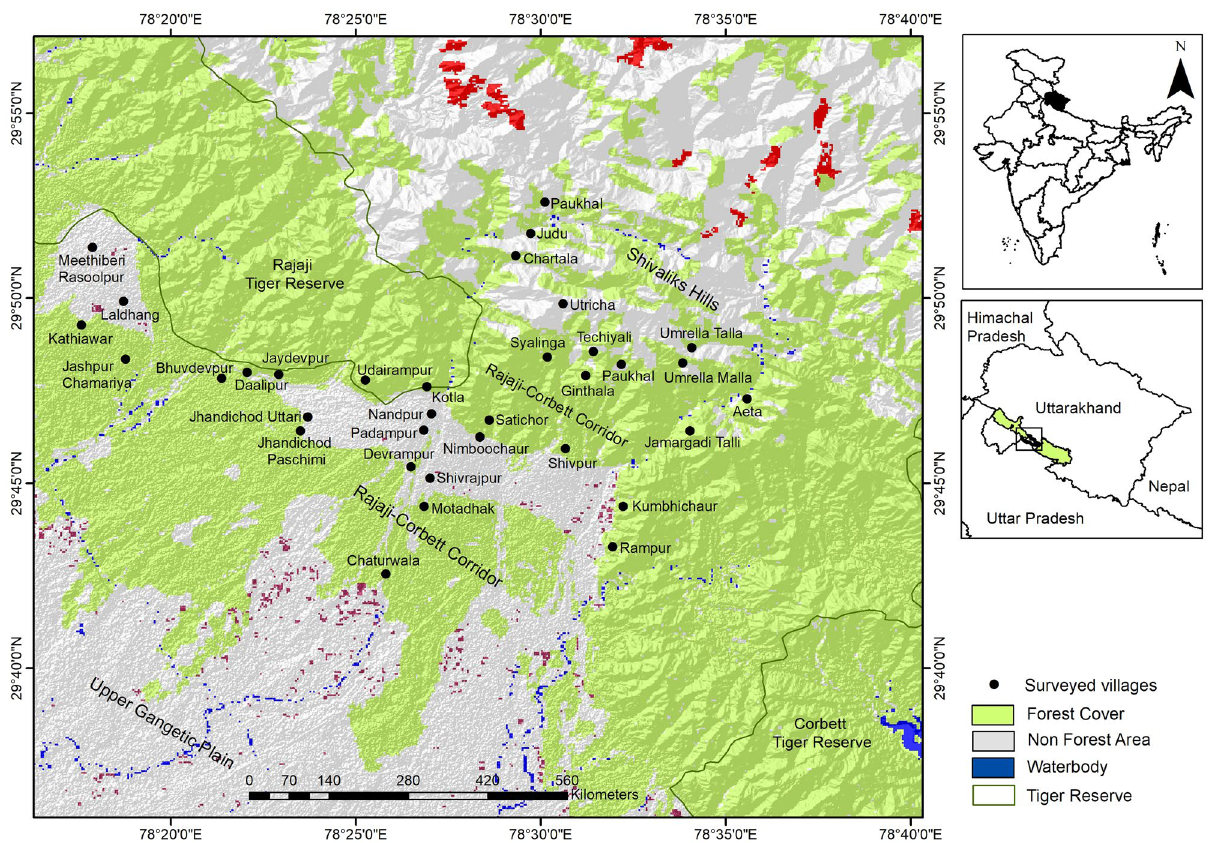
Figure 5. Map highlighting the forest corridor linking the Rajaji and Corbett Tiger Reserves, and the locations of the sampled villages in Uttarakhand, India. Land cover used was downloaded from Diva-Gis (http://www. diva-gis.org/gdata ). The map was created using ArcGIS v.10.3.1 software developed by ESRI (https ://www.esri.